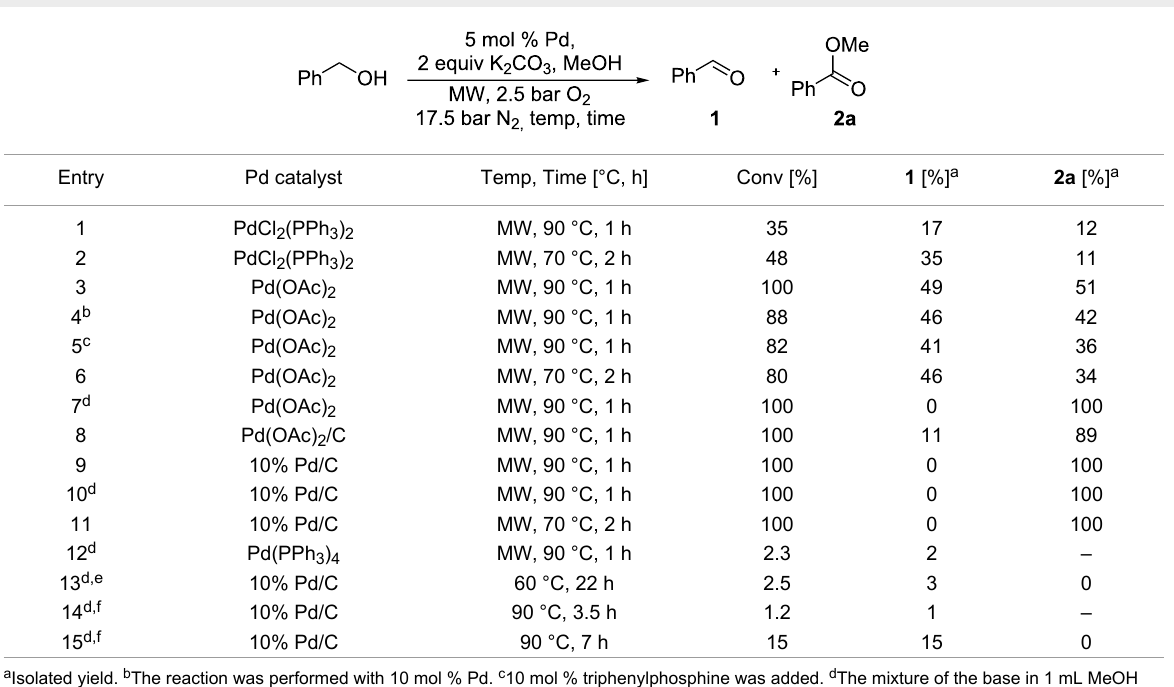
Table 1: Oxidative esterification of benzylalcohol with methanol.